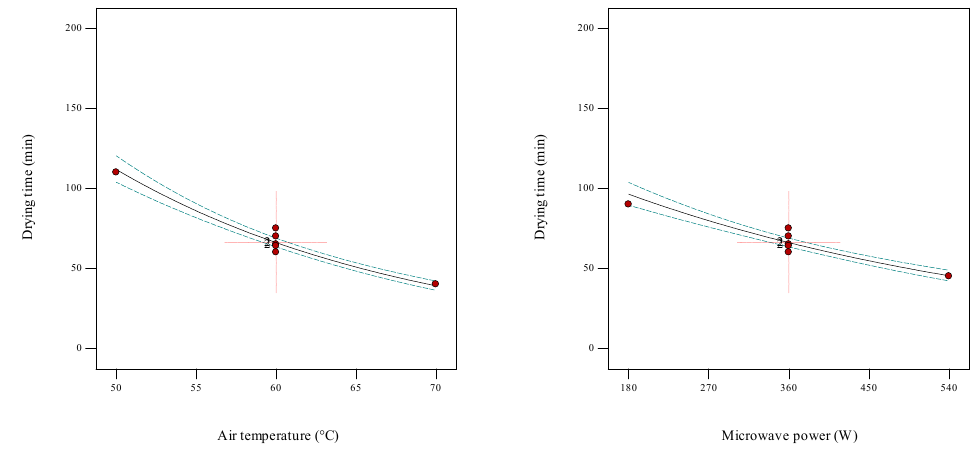
Figure 2. The effect of air temperature and microwave power alone on drying time.